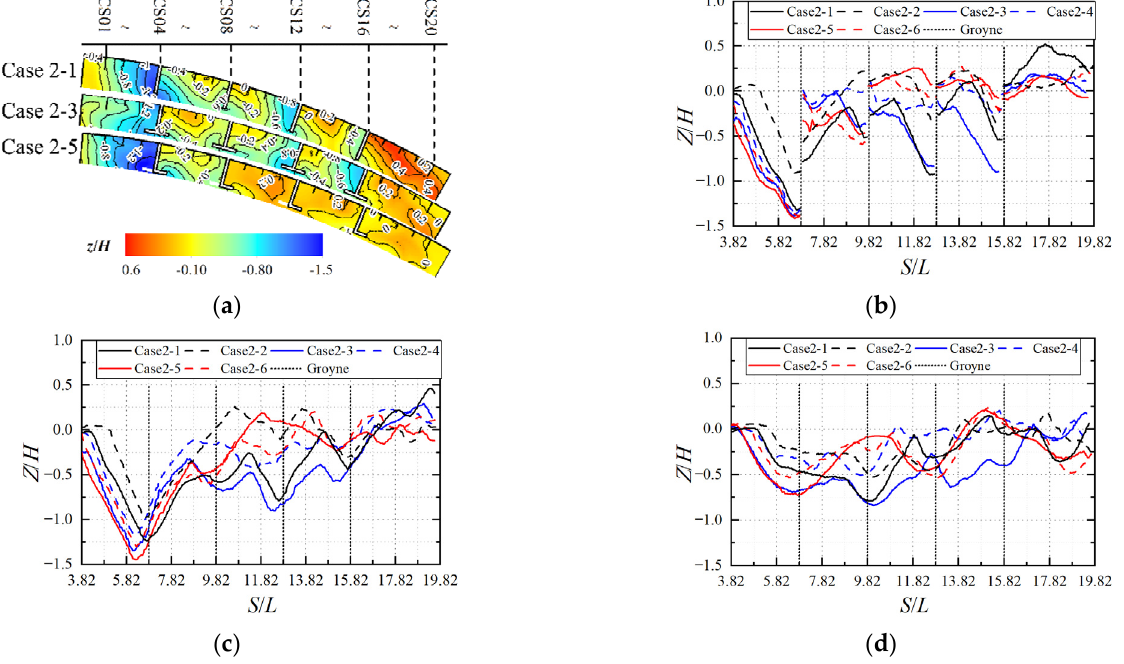
Figure 10. Bed topography: ( a ) topographic elevation of groin field (Case 2-1, 2-3, 2-5), ( b ) terrain elevation ( N / L = 0.5), ( c ) terrain elevation ( N / L = 1.01) and ( d ) terrain elevation ( N / L = 2.5).